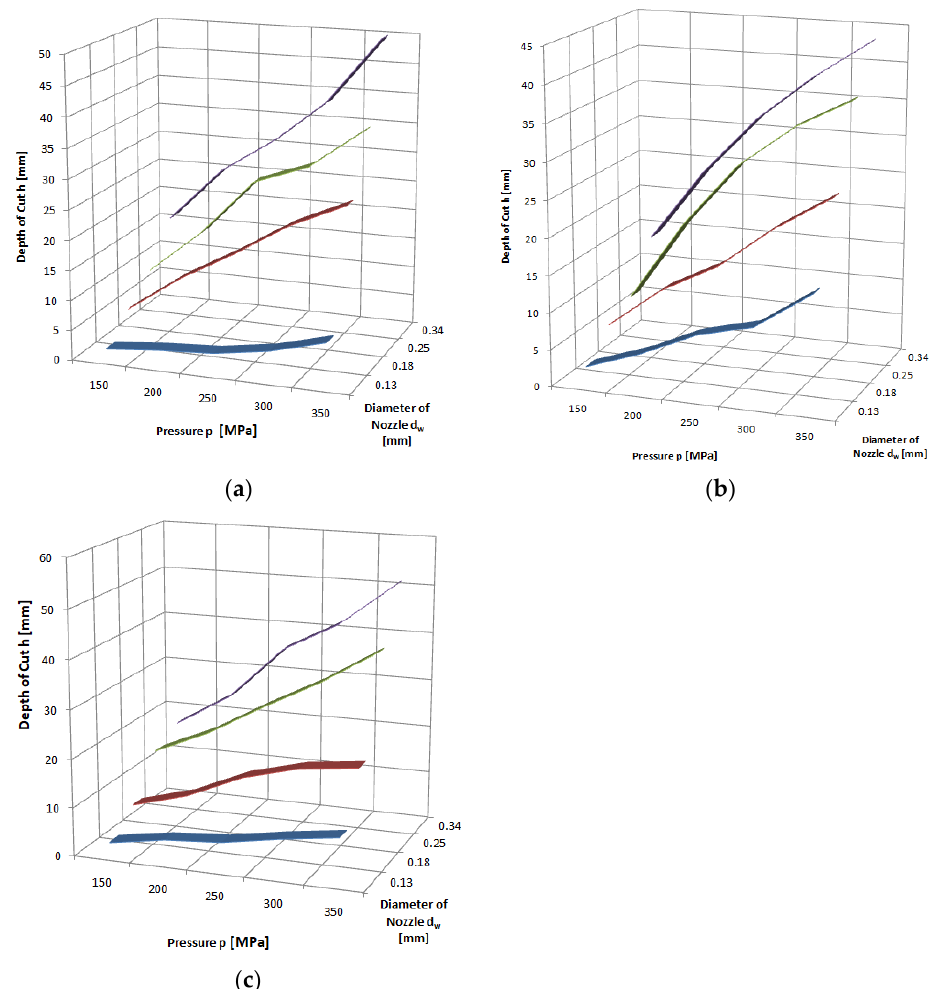
Figure 7. Influence of pressure and waterjet diameter on cutting depth of: ( a ) marble; ( b ) basalt; ( c ) limestone, with abrasive waterjet: feed speed v p = 3 mm·s − 1 , abrasive flow rate 𝑚(cid:4662) (cid:3028) = 6.7 g·s − 1 .